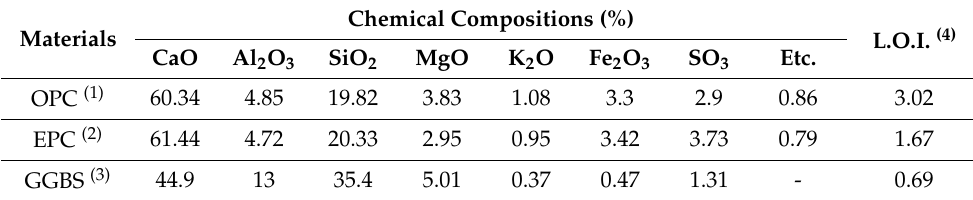
Table 2. Chemical compositions on used